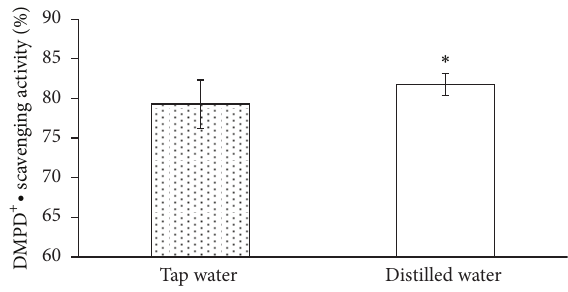
Figure 3: Effects of water solution on DMPD + ∙ scavenging activity in green tea.